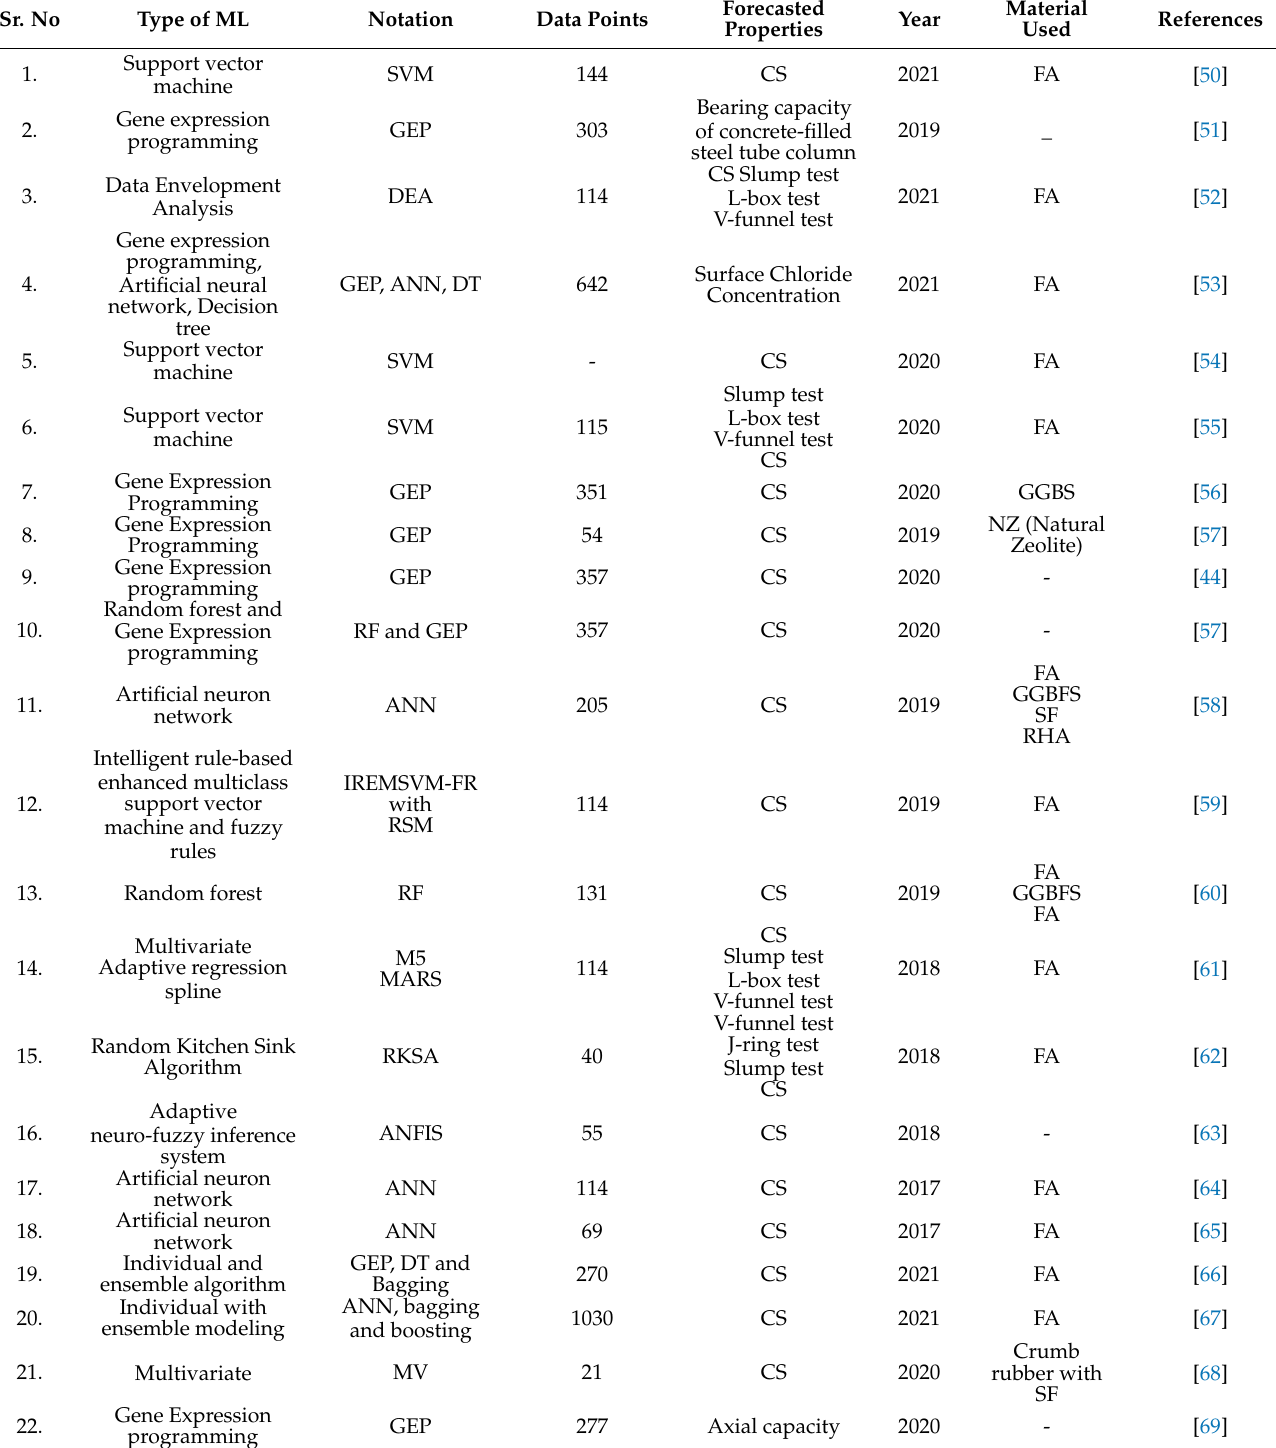
Table 1. Prediction properties details via supervised machine learning